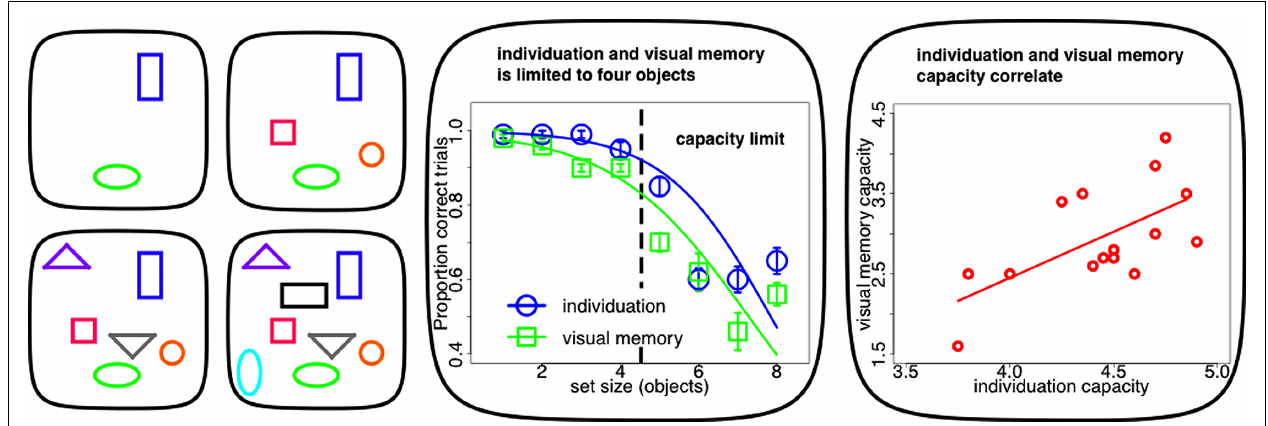
set-size. Both tasks show a limit of up to four objects.The inflection point of the sigmoid curve fit to the psychophysical data can be used to estimate individual capacity limits. Right panel: single-subject correlation between individuation and visual memory capacity. Limits in visuo-spatial object processing correlate across subjects and individuation usually exceed visual memory limits (Figures adapted with permission from Piazza etal., 2011).